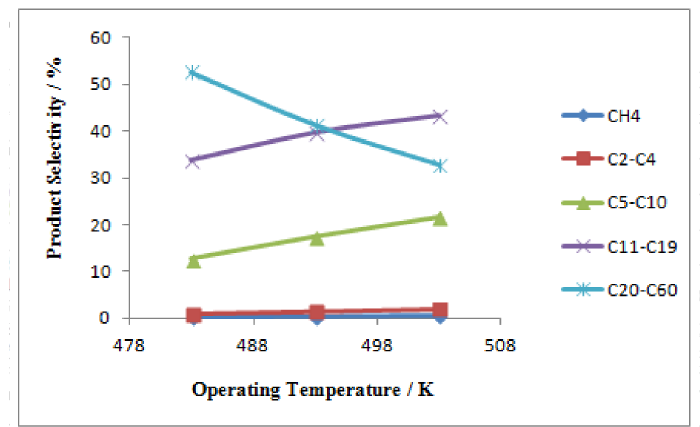
Figure 11. Influence of operating temperature on product selectivity; D t =0.1 m, H = 2.5 m, V f = 7.5 m 3 /h, P = 20 bar, ε cat =